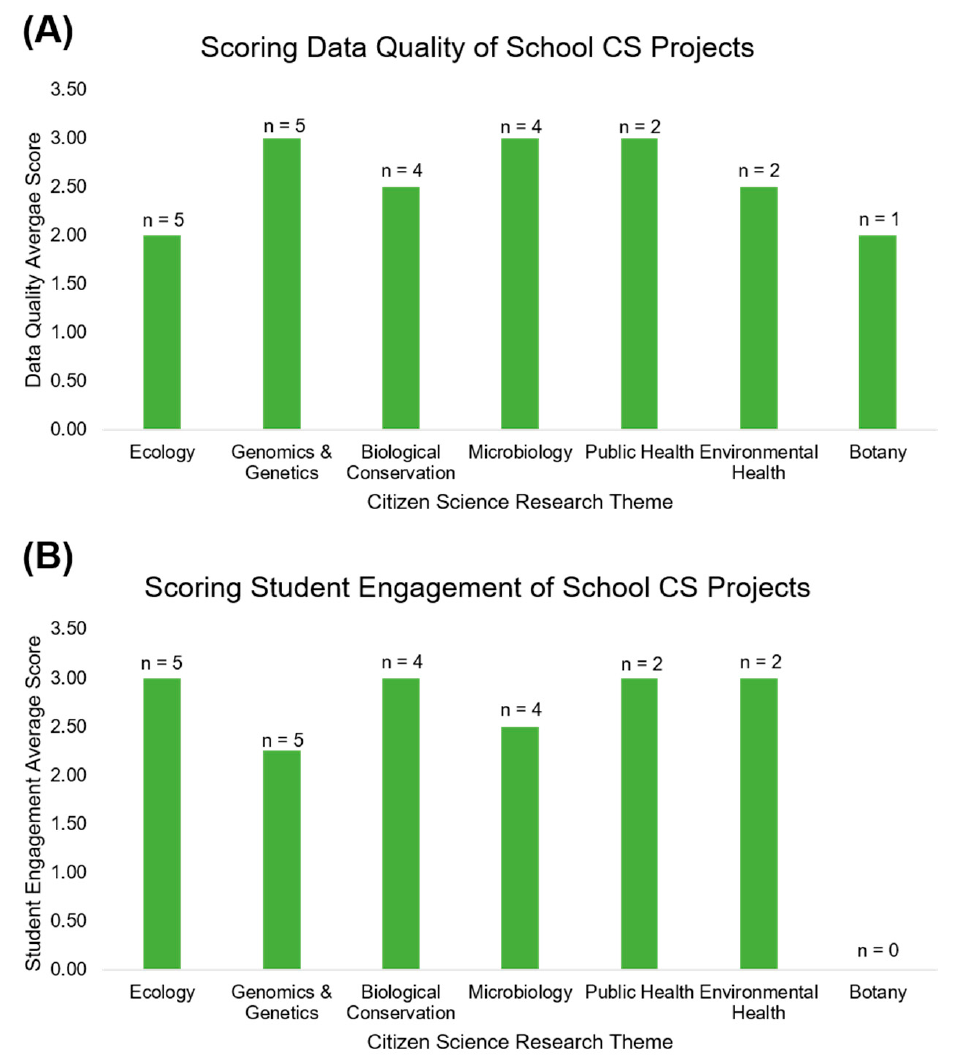
Figure 2. ( A ) Bar chart of the average scores for data quality in each citizen science research theme. ( B ) Bar chart of the average scores for student engagement in each citizen science research theme. Scores were from 0–3 (not mentioned, low, moderate,